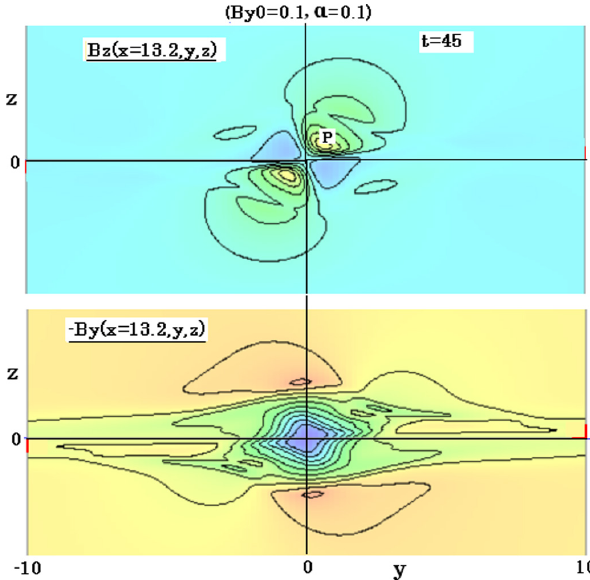
Fig. 9. Distributions of B z and − B y (contour interval of 0 . 1) at t = 45 for the case of B y0 = 0 . 1 and α = 0 . 1 in the cross section at x = 13 . 2.